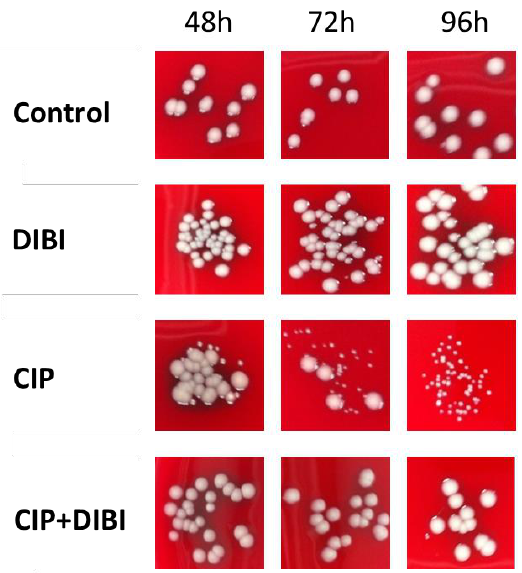
Figure 4. Effects of ciprofloxacin and DIBI on Staphylococcus aureus small colony variant formation. S. aureus ATCC 25923 was grown in MHB and a standardized inoculum added to 10 mL flask cultures of untreated RPMI control, RPMI with added 50 µ g/mL, 0.5 µ g/mL CIP or 50 µ g/mL DIBI combined with 0.5 µ g/mL CIP. Samples taken during exposure were plated onto BA for enumeration of total CFU/mL and the percentage of SCV in the recovered population. All pictures are at the same final magnification and representative of two independent experiments.